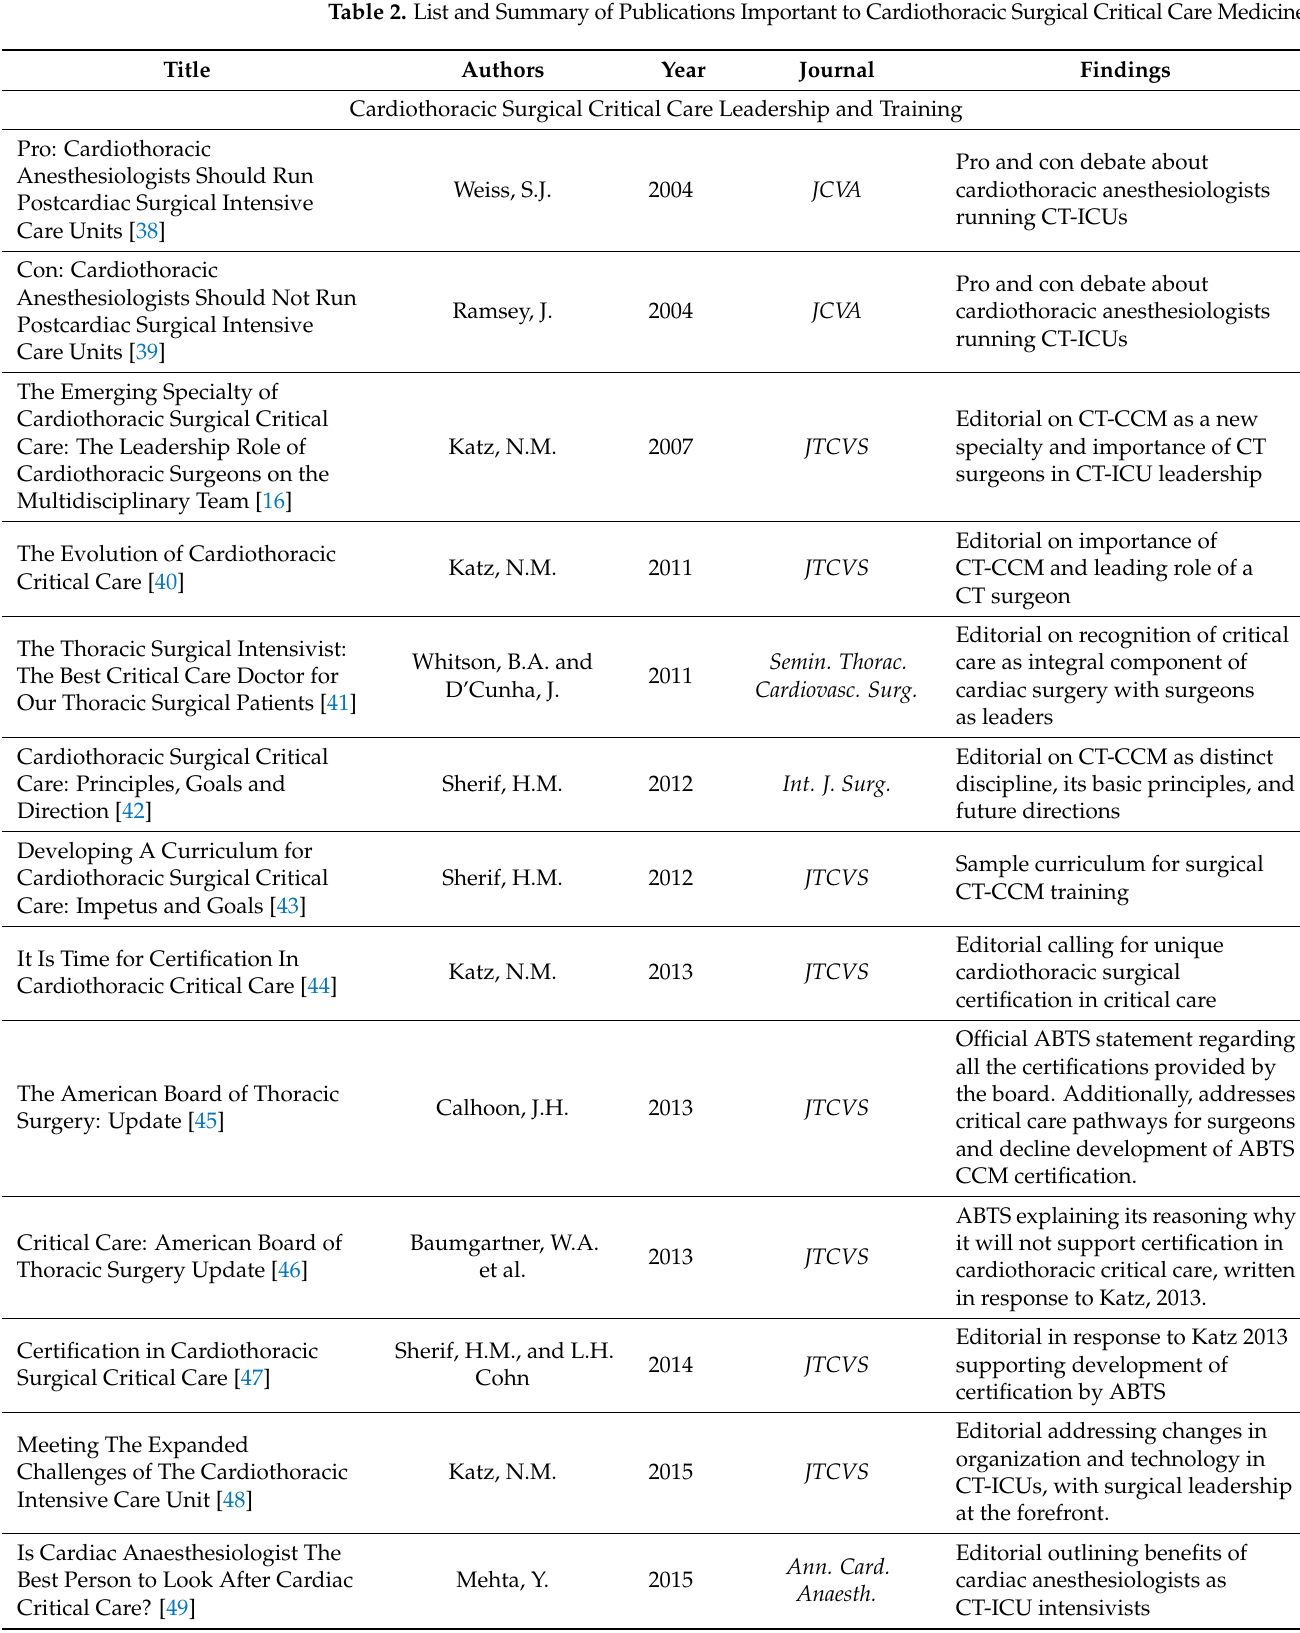
Table 2. List and Summary of Publications Important to Cardiothoracic Surgical Critical Care